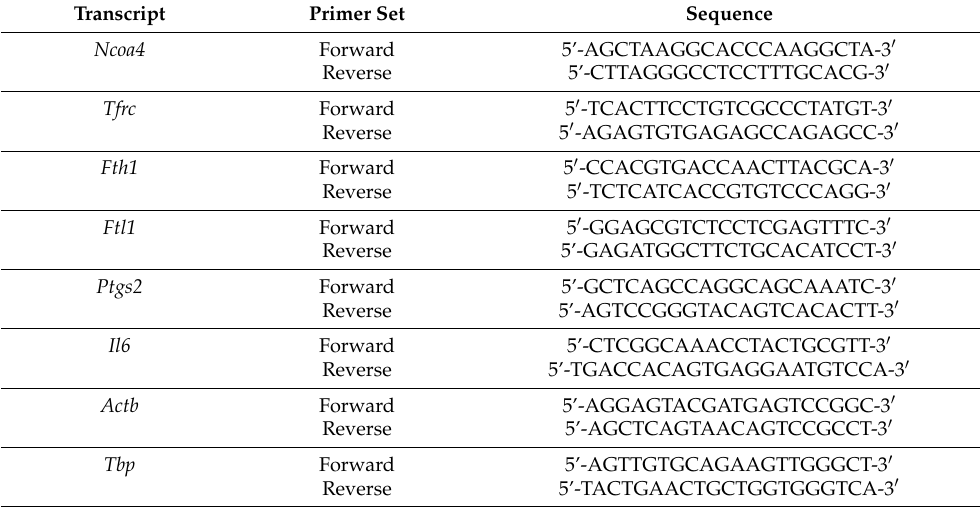
Table 1. qPCR Primer